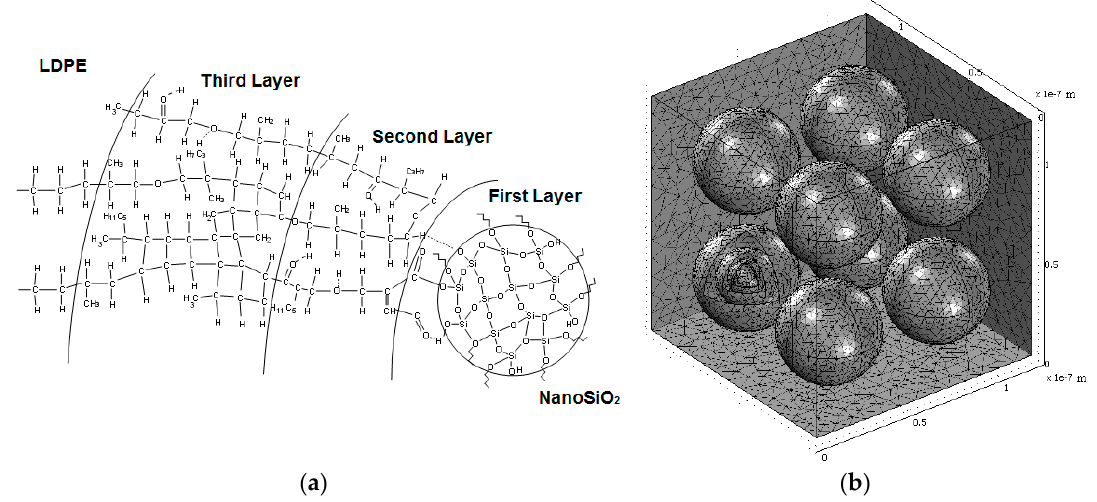
Figure 13. ( a ) Schematic representation of an interface LDPE—nanoSiO 2 chemical structure and ( b ) 3D electrostatic model (Reprinted, with permission, from author [84]).